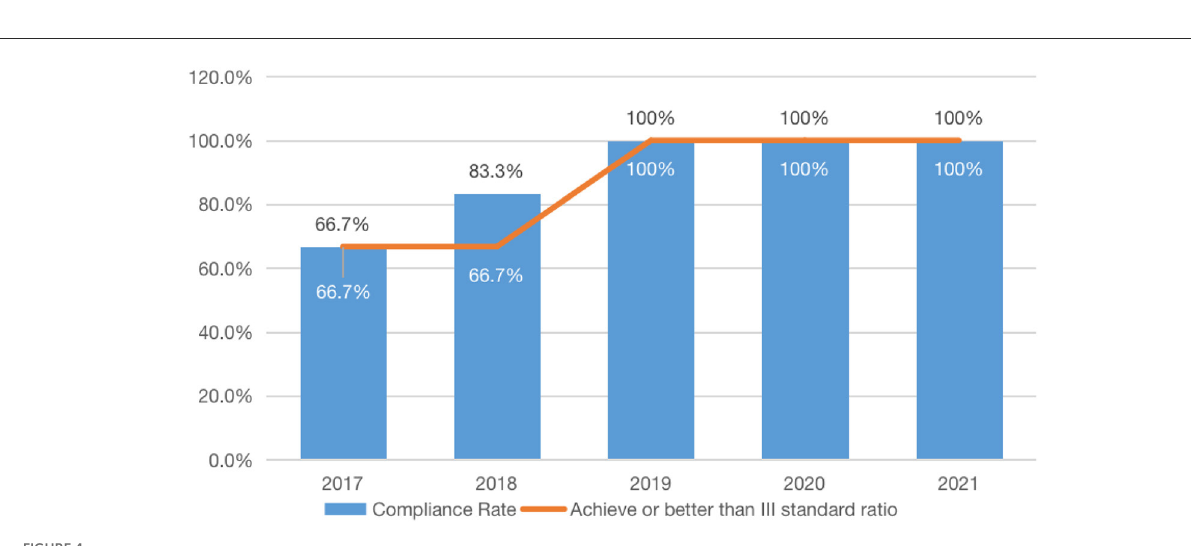
FIGURE4 The water environment-related indicators of the Grand Canal (Hangzhou section) between 2017 and